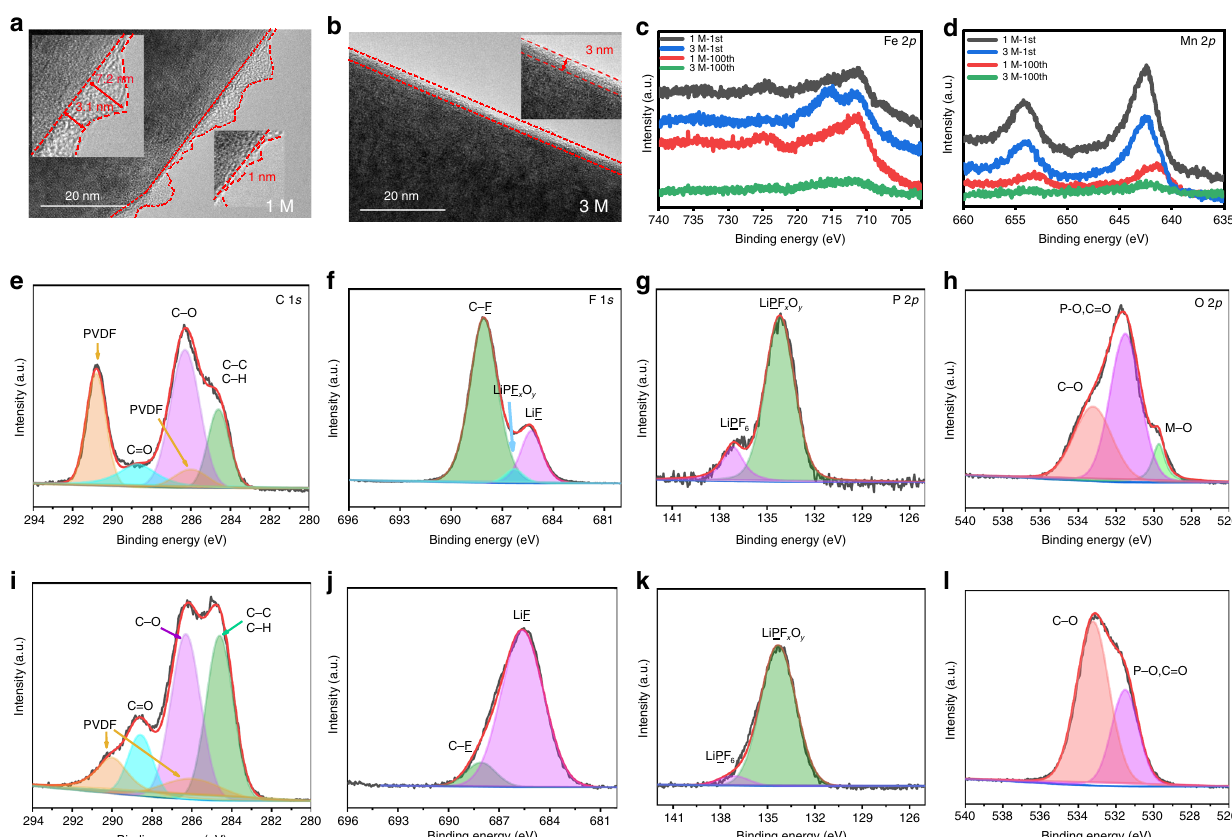
Fig. 5 Electrode passivation in 1 and 3 M electrolytes. a , b HRTEM images of electrodes after cycling in 1 and 3 M electrolyte, respectively; c , d XPS spectra of Fe 2 p and Mn 2 p on the electrodes cycled in 1 and 3 M electrolyte after 100 cycles at 0.1C, respectively; e – h C 1 s , F 1 s , P 2 p , and O 2 p spectra on the cycled electrode in 1 M electrolyte; i – l C 1 s , F 1 s , P 2 p , and O 2 p spectra on the cycled electrode in 3 M